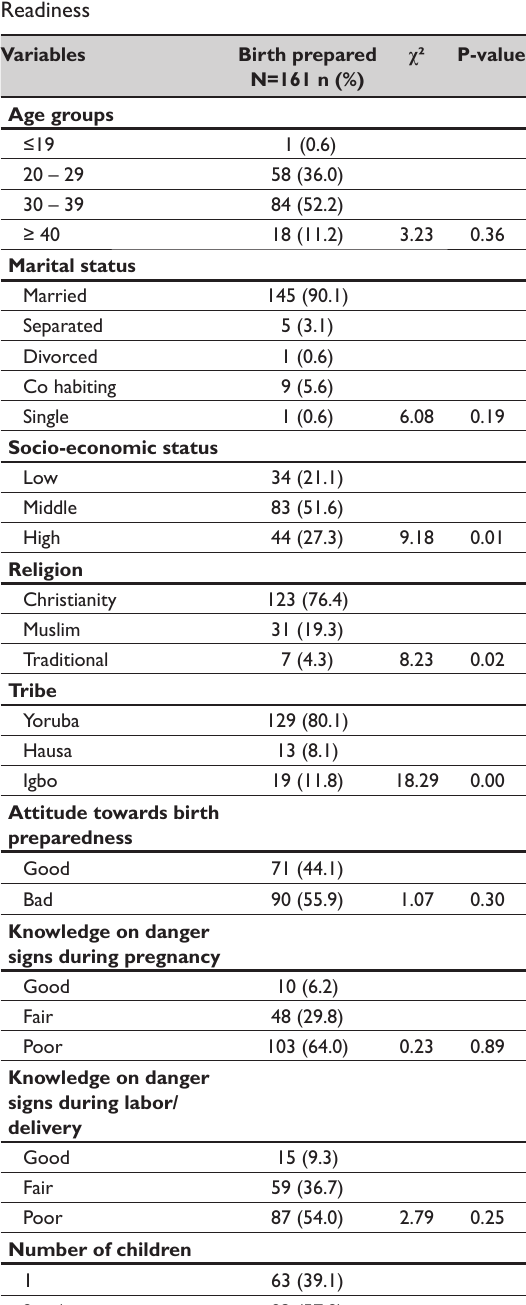
Table 2. Association between